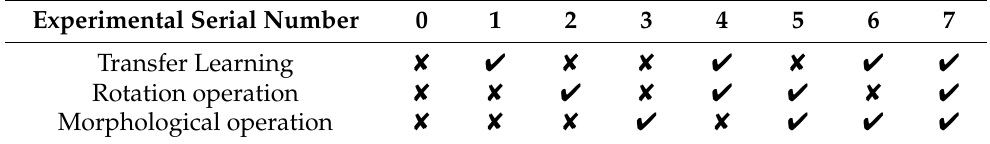
Table 4. The design of the ablation